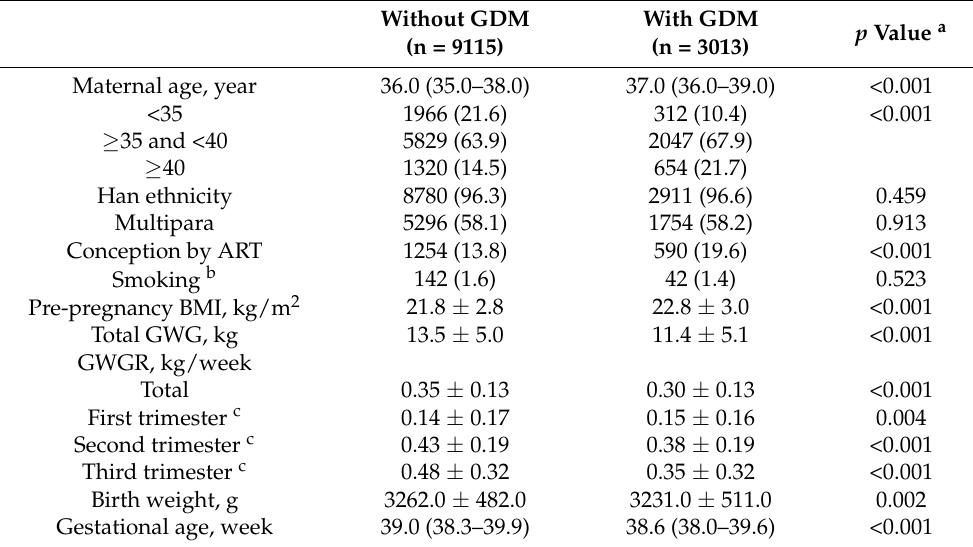
Table 1. Baseline characteristics of study